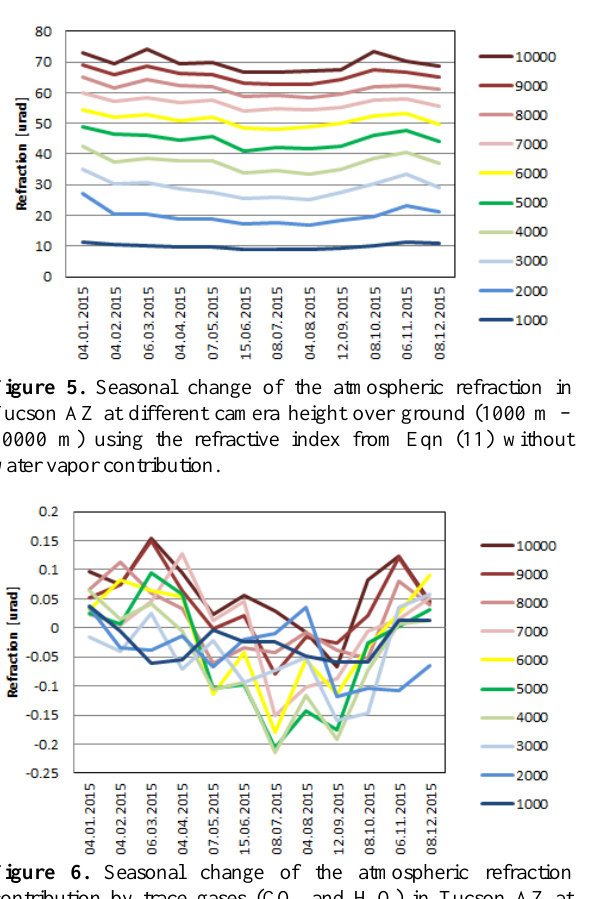
Figure 4. Seasonal change of the precipitable water column at Tucson AZ measured at 00 UTC.